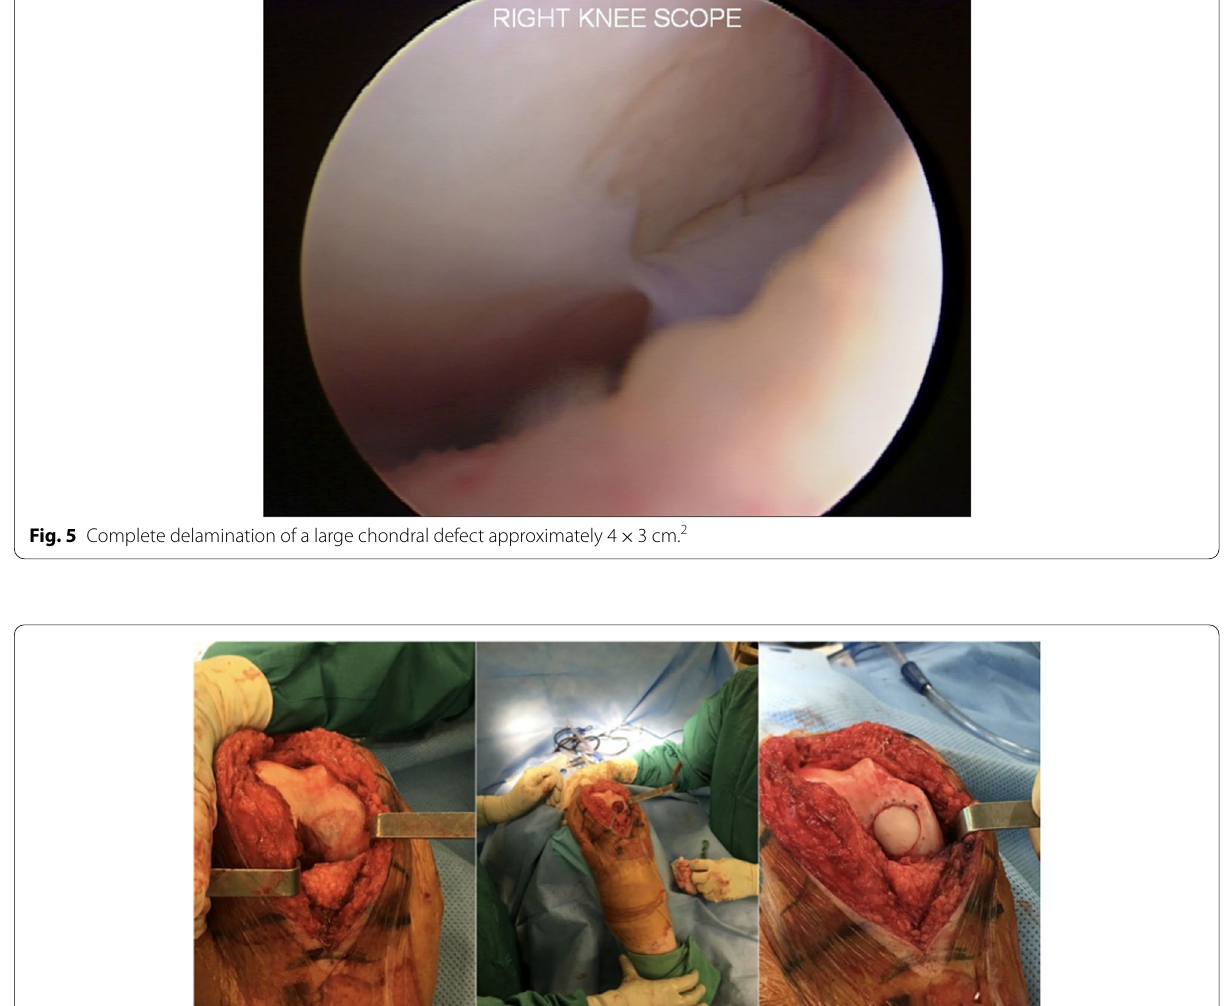
Fig. 6 After acute delamination was demonstrated, osteochondral allograft was applied to the defect in the medial femoral condyle. 439 193 mm. 2 (144 144 × ×